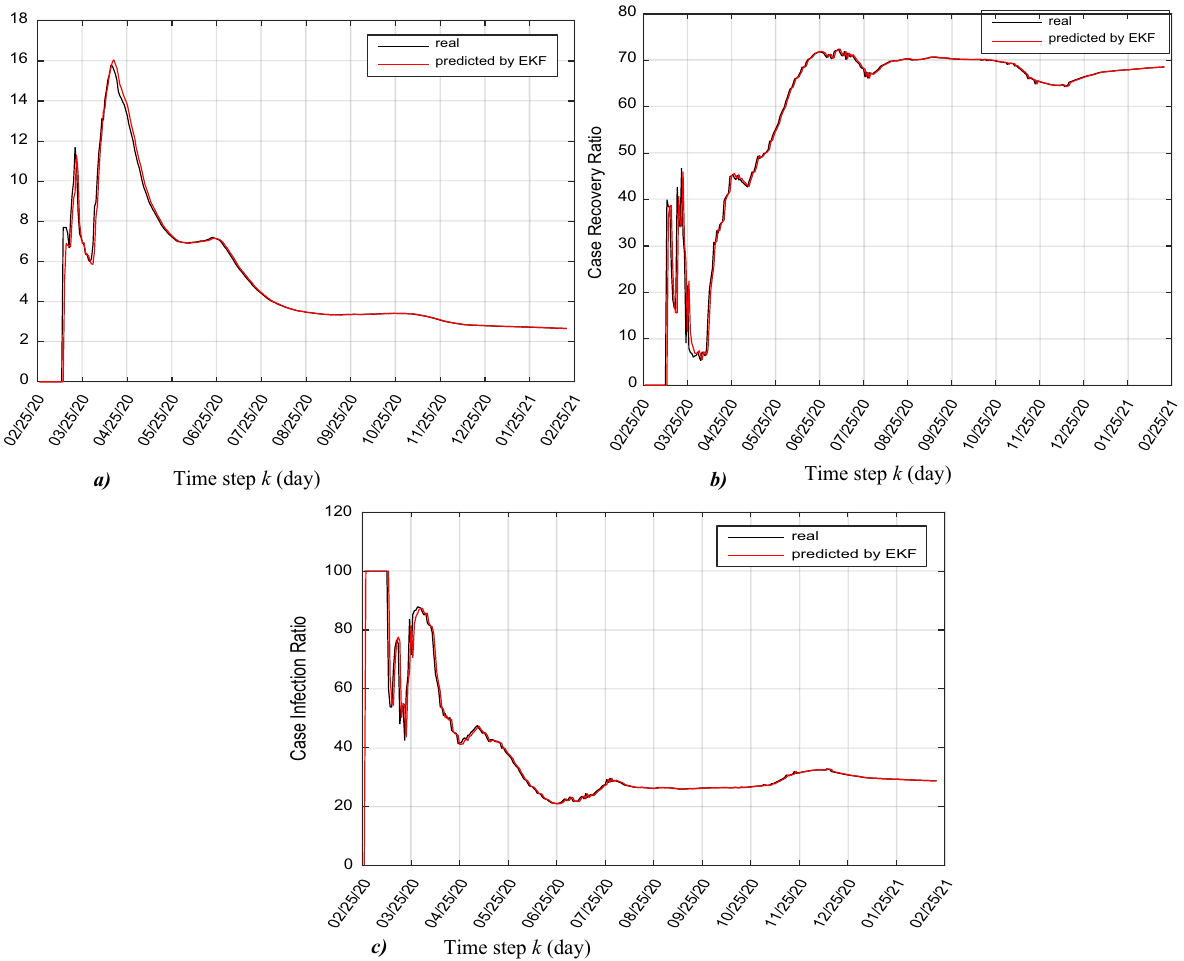
Figure 7. Real and predicted trajectories, ( a ) case fatality ratio, ( b ) case recovery ration and, ( c ) case infection